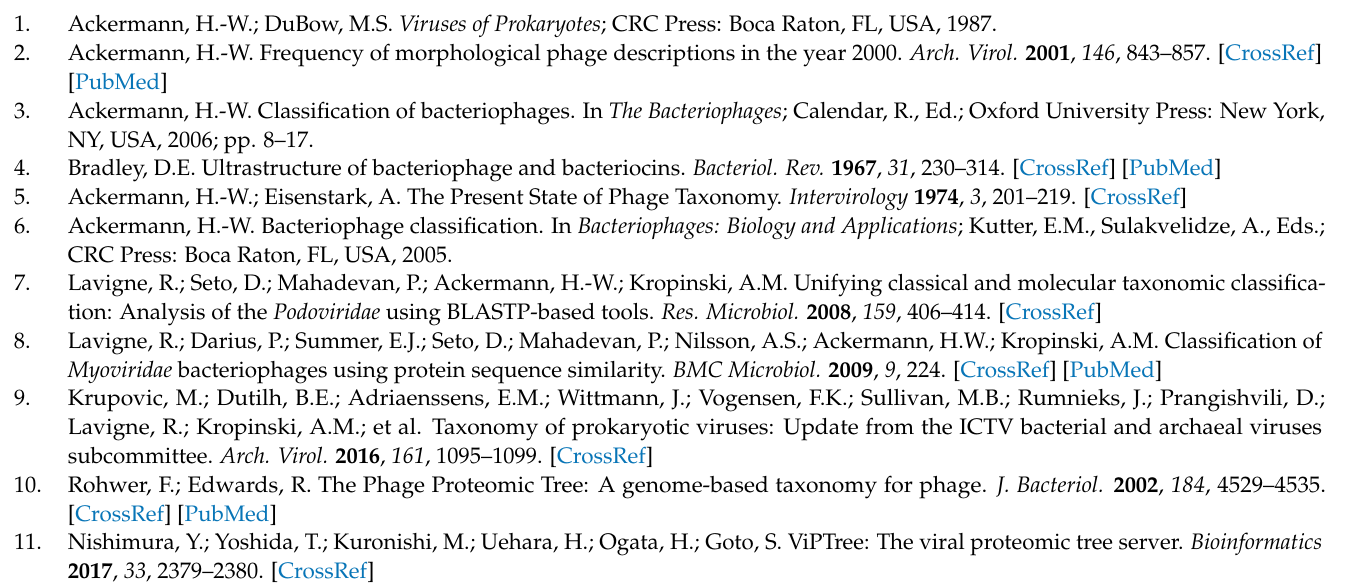
panion information for Figure 2. The clusters corresponding to eukaryotic family level cut-offs were automatically indicated on the figure as part of the pipeline using genus, subfamily and our family information. Figure S2: vContact2 network illustrating families of the viruses of bacteria. Phage genomes were downloaded from GenBank on the 22 February 2021, representing a total of 14,462 sequence records, and reannotated using Prokka via the INfrastructure for a PHAge Reference Database perl script (https://github.com/RyanCook94/inphared.pl (accessed on 5 February 2021)). vContact2 version 0.9.21 was used to cluster phage genomes using the parameters –rel-mode ’Dia- mond’, db ’None’, pcs-mode MCL and vcs-mode ClusterONE. The resultant network was visualised in Cytoscape v3.8.2 and annotated using a custom python script and Adobe Illustrator. ICTV-ratified families are shown in italic font, while pending proposals for new families are shown in Roman font. Putative phage genomes from metagenomic sequence data held in the Sequence Read Archive are not included, therefore, phages belonging to the classes Leviviricetes, Tokiviricetes, Laserviricetes and the proposed new order “ Crassvirales ” are under-represented in this network and their depiction may not be an accurate